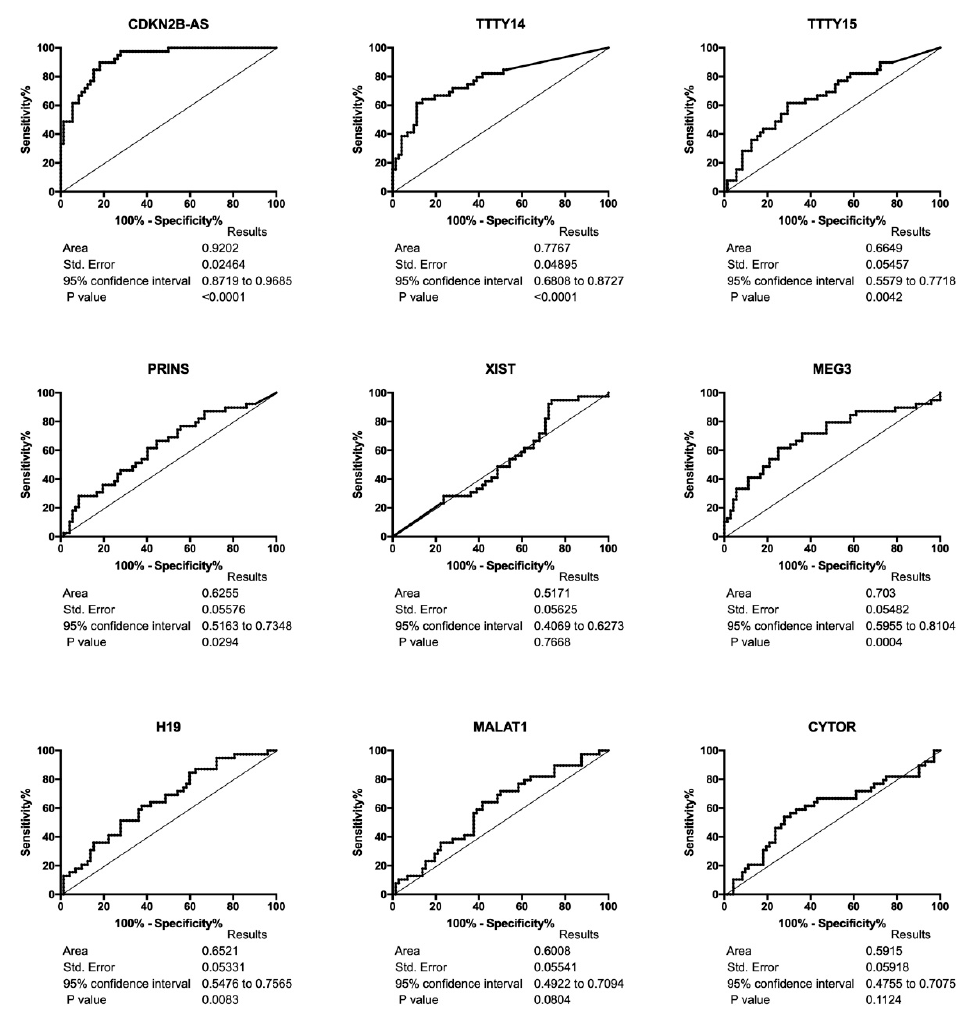
Figure 2. Receiver operating characteristic curve (ROC) analyses of CDKN2B-AS1, TTTY14, TTTY15, PRINS, XIST, MEG3, H19, MALAT1, and CYTOR lncRNAs in HPV( − ) and HPV( + ) HNSCC patients.